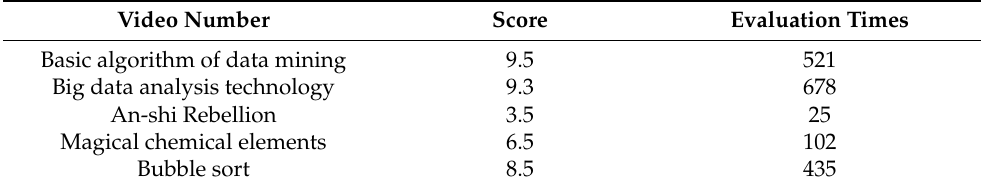
Table 9. Scoring and evaluation Times.